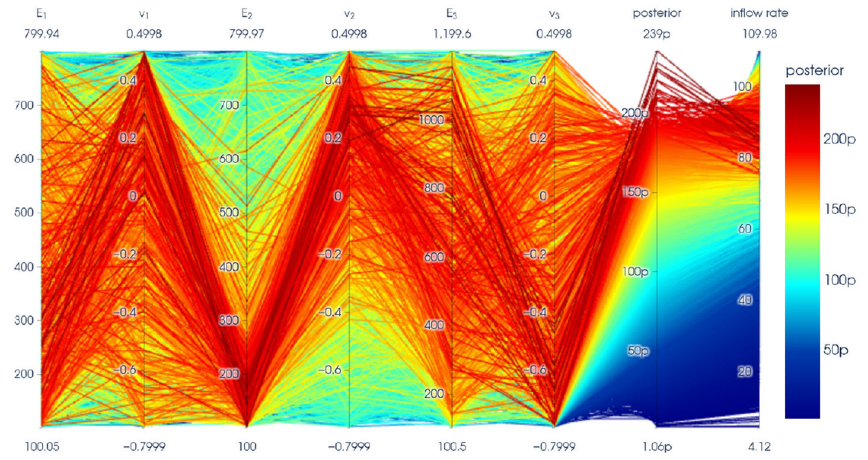
(cid:2) (cid:3) x | θ ,Y and inflow rate for all particles of the obs ,C